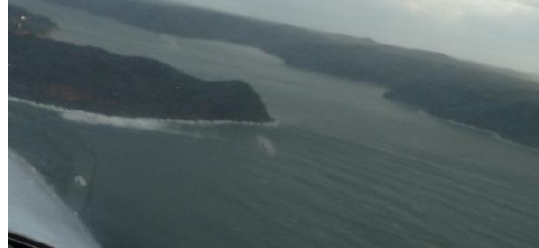
Figure 10. Sea surface conditions viewed from the